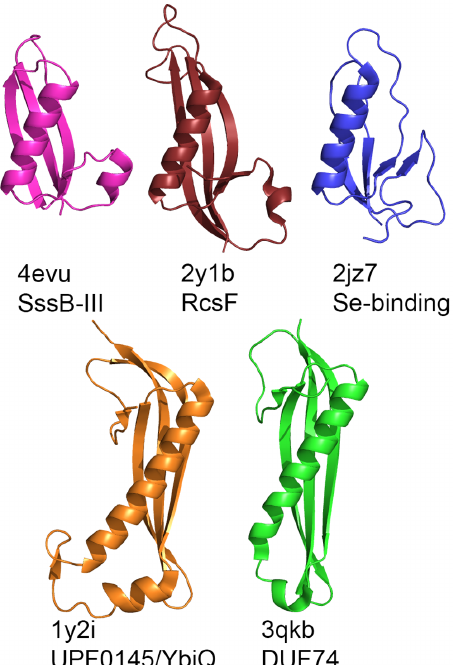
Figure 3. Proteins structurally similar to DUF1471 proteins. Similar structures were identified with Dali [20]. Additional details are presented in Table 4. doi:10.1371/journal.pone.0101787.g003 PLOS ONE |